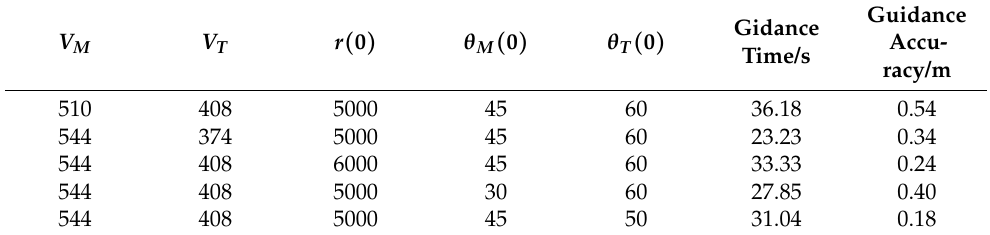
Table 7. Performances of different initial conditions with square wave maneuver.